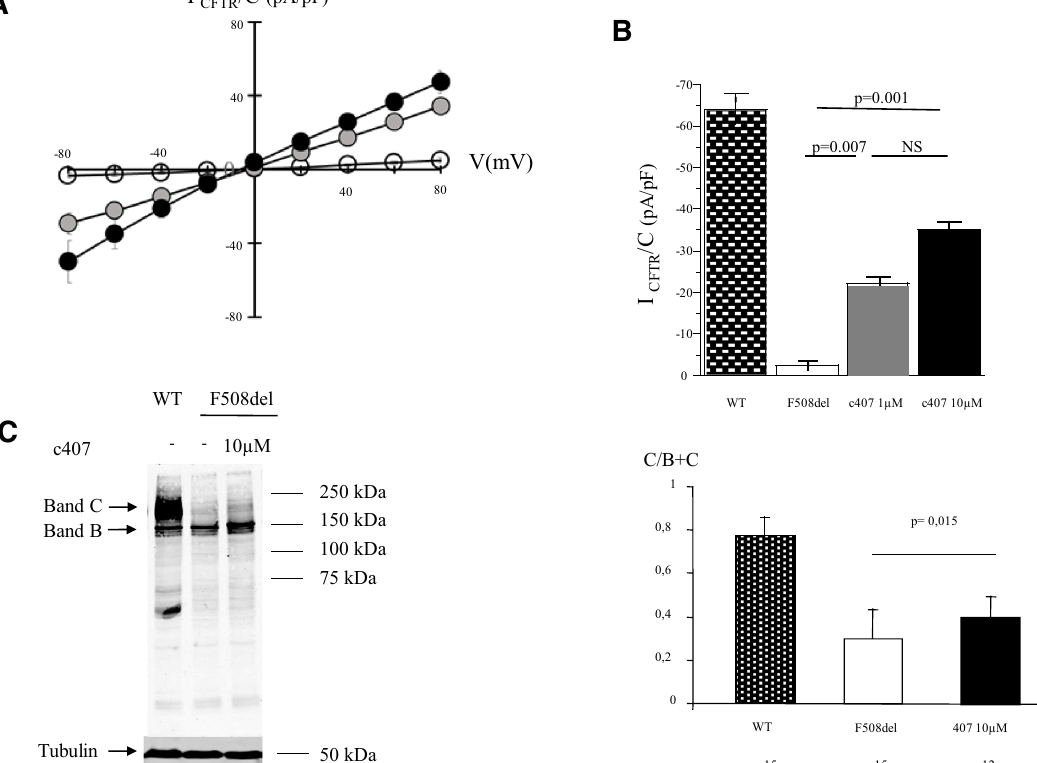
Figure 1. c407 activity in HeLa cells and Human nasal primary cells. ( A ) Whole cell patch-clamp experiments. Mean (SEM) CFTR-related current/voltage relationships obtained in HeLa cells stably expressing F508del- CFTR after 48 h incubation with NaCl 0.9% (empty circle, n = 5); c407 1 µM (grey circle, n = 14) and 10 µM (black circle, n = 9). Current densities normalized to cell capacitance (I CFTR /C) were calculated as the differences between current values in the presence of CPT-cAMP 400 µM/IBMX 100 µM minus current values after inhibition with CFTRinh-172 5 µM. ( B ) Summary of the mean CFTR current amplitudes recorded at − 60 mV and normalized to cell capacitance of the experiments in A. Results are also shown for Wild Type (WT) CFTR cells (black dotted; n = 10). Wilcoxon-test statistics are shown. ( C ) Immunoblot of HeLa cells stably expressing F508del-CFTR after incubation with c407 at 10 µM for 48 h, and NaCl 0.9% as negative control. Arrows indicate CFTR immature core glycosylated band B and complex glycosylated mature band C. CFTR was immunoblotted with monoclonal CFTR antibody 660, at 1:1000. Representative experiments of n = 12. ( D ) Summary of CFTR expression quantification. CFTR expression is evaluated by the ratio C/B + C. The ratio is significantly higher in F508del-HeLa cells incubated with c407 at 10 µM (n = 12 different experiments) versus F508del-HeLa cells incubated with control water (n = 15); p = 0.015 (Wilcoxon non parametric